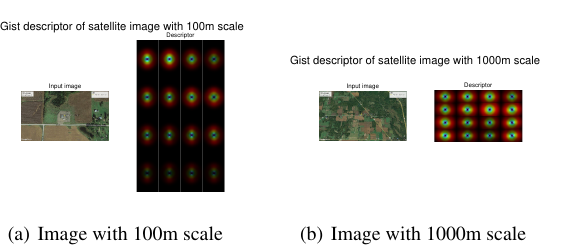
Figure 2. Architecture of proposed methods